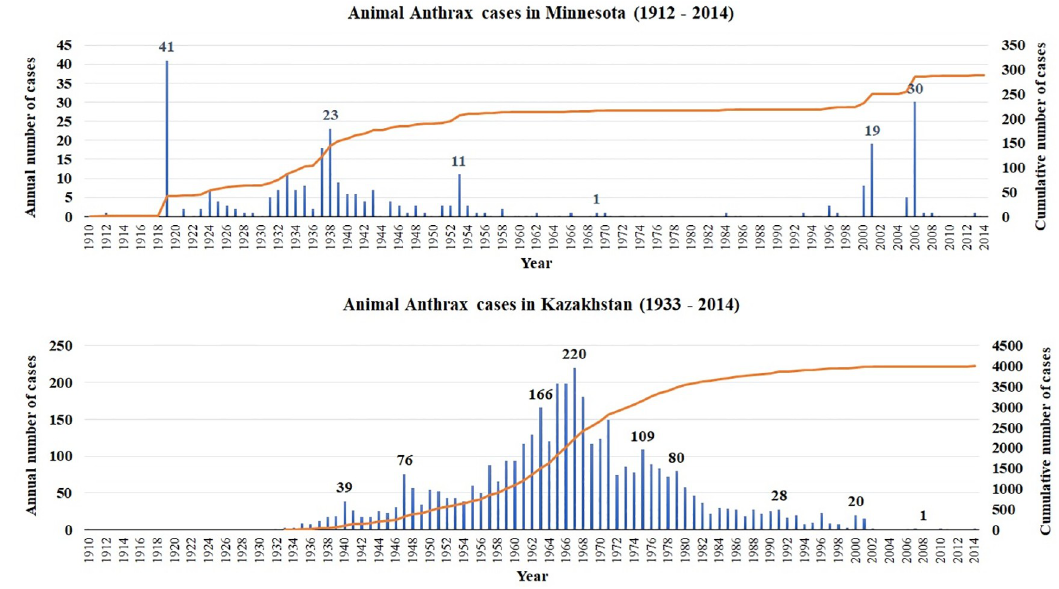
Fig 1. Epidemic curves illustrating the number of animal Anthrax outbreaks. Outbreaks were reported between 1912 and 2014 in Minnesota and between 1933 and 2014 in Kazakhstan (Bars indicate annual number of reported cases, left axis, and lines indicate cumulative number of cases, right